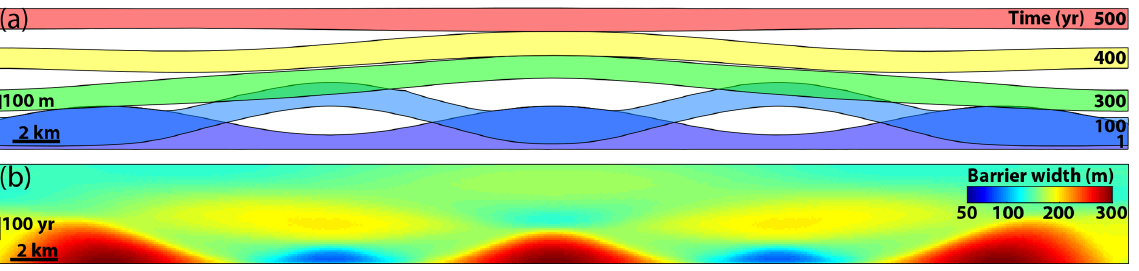
Figure 5. BRIE without inlets showing barrier response to variations in the initial back-barrier position x b (see also Ashton and Lorenzo- Trueba, 2018), (a) x s , and x b at five instances; (b) barrier width as a function of time. Minima in barrier width drive faster transgression, which in turn results in wider barriers through the accumulation of alongshore